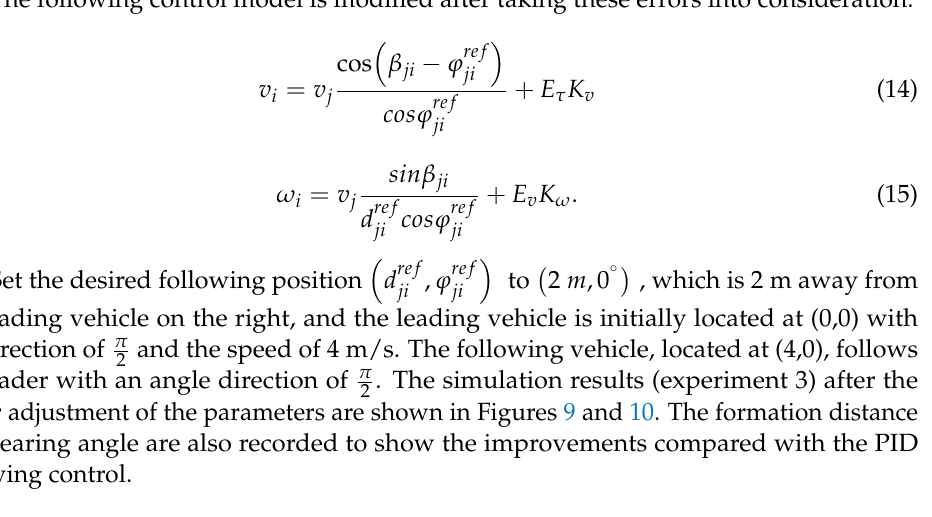
Figure 8. Illustration of the deviation E.